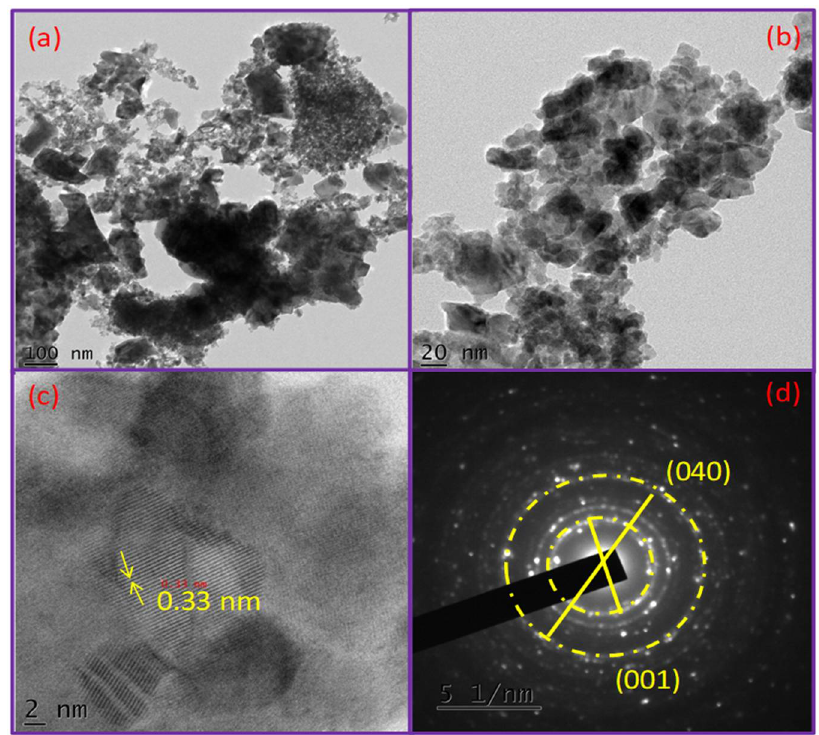
Figure 6. ( a , b ) TEM, ( c ) HR-TEM and ( d ) selected area electron diffraction (SEAD) pattern of β- SnWO4 nanoparticles.